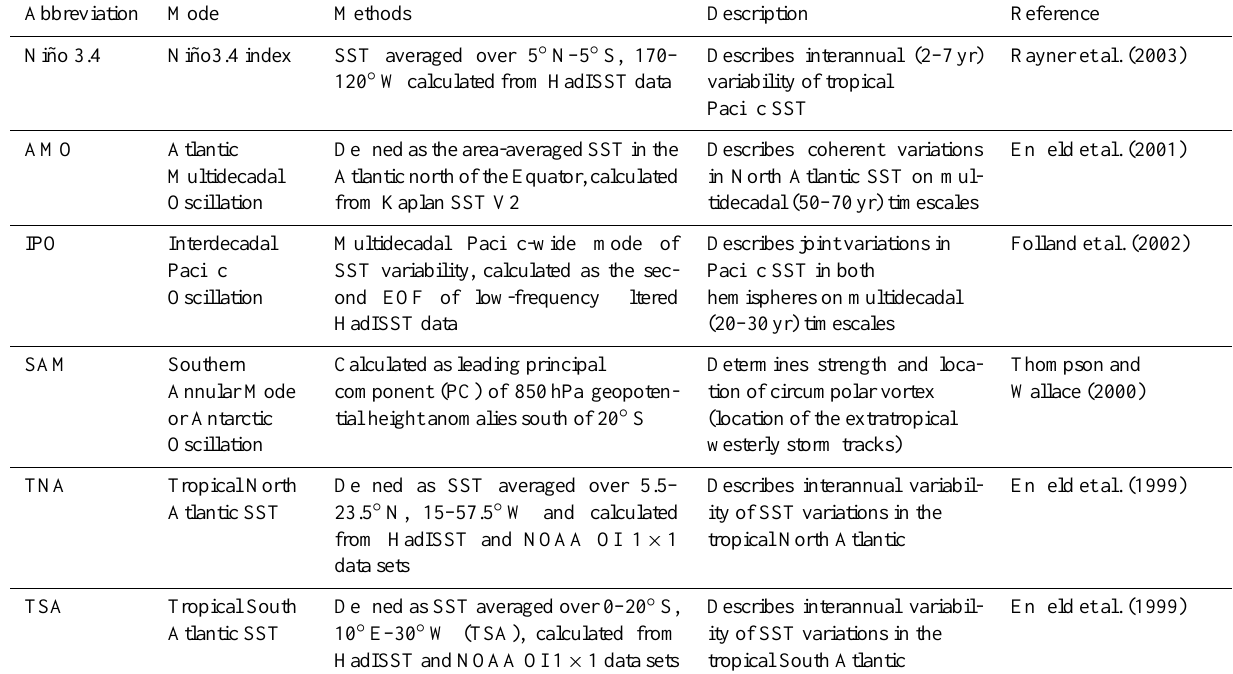
Table 1. Climate modes used relevant for South America. SST: sea surface temperature; HadISST: Hadley Centre Global Sea Ice and Sea Surface Temperature; EOF: empirical orthogonal function; NOAA OI: National Oceanic and Atmospheric Administration Optimum